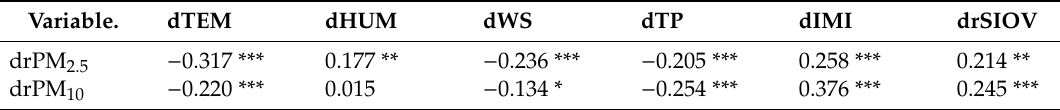
Table 4. Pearson Correlation Coefficients between 6 independent variables and 2 dependent variables. Variable. dTEM